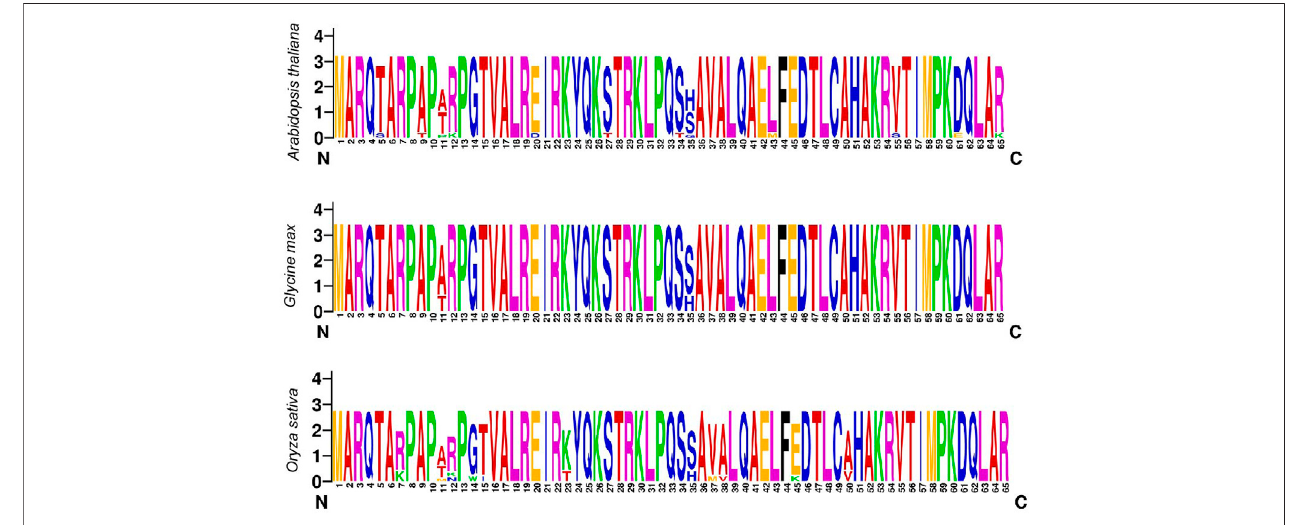
FIGURE 2 | Sequence logos of conserved amino acid residues generated for three species.